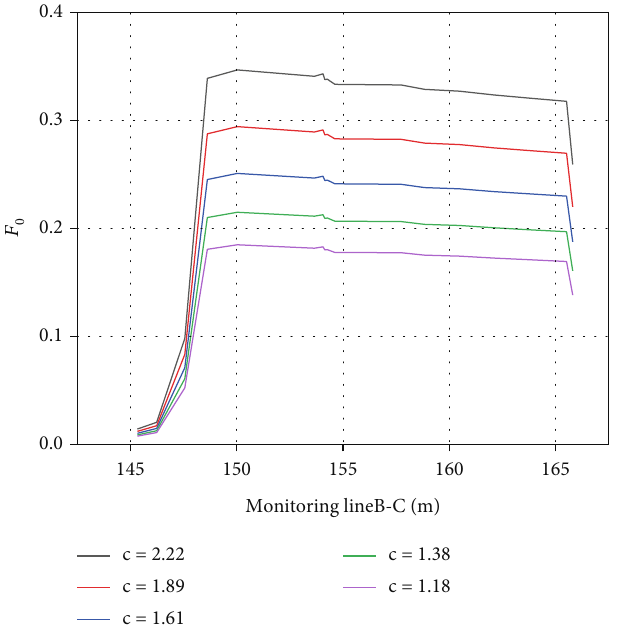
β = 10 and di ff erent c